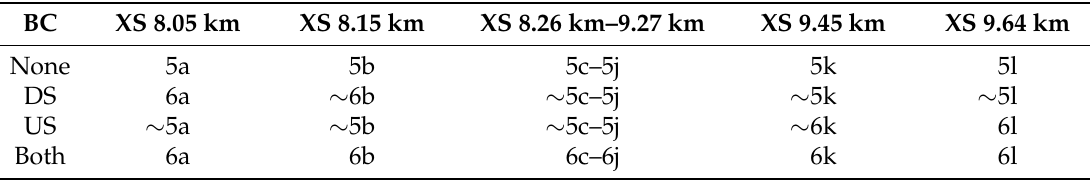
Table 3. Summary of two-dimensional projection subplots of all particles by Figures 6 and 7. A symbol indicates a similar pattern to the subplots given on the right. Figures 6c–j and 7c–j, ∼ respectively, have a similar